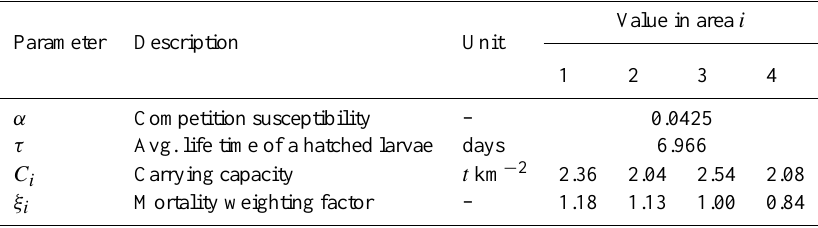
Table 3. Inferred biotic/abiotic parameters in the SPAM model obtained from residual minimization.